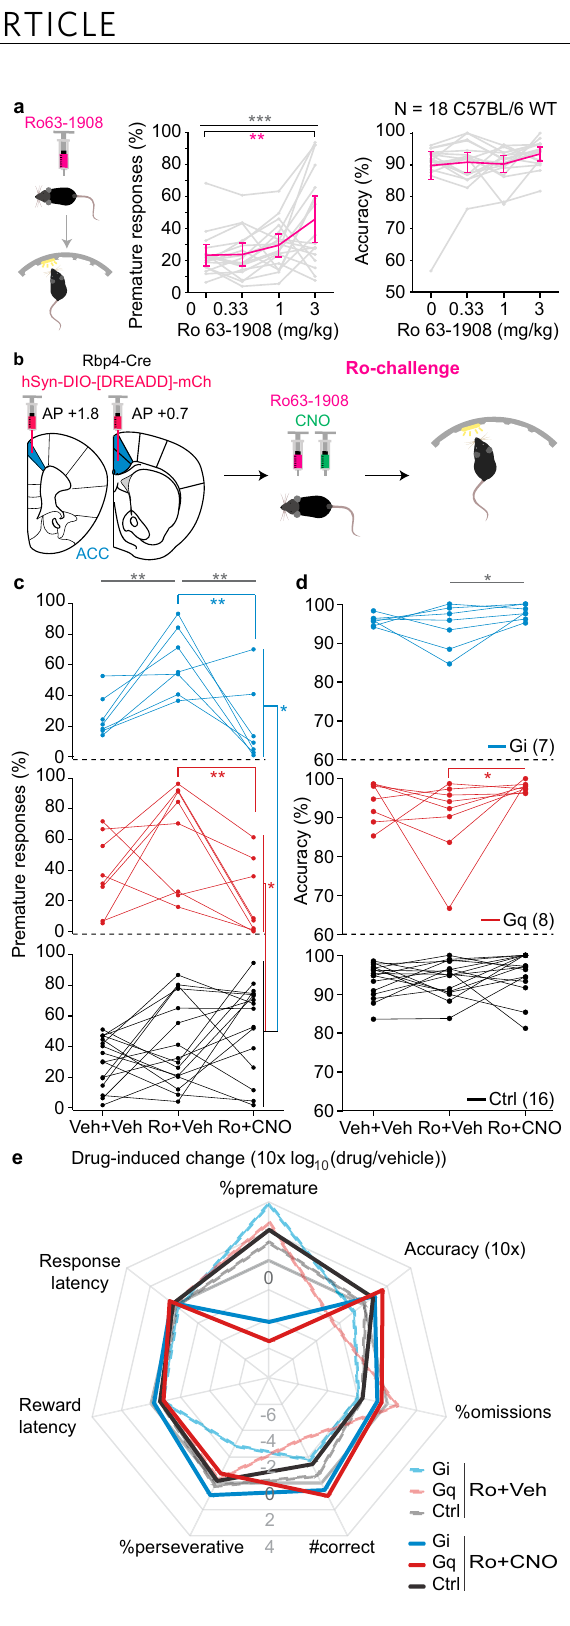
Fig. 3 Activation of the G i -cascade in ACC L5-PCs reduces premature responding in a pharmacological challenge of impulsivity. a Premature responding and accuracy after injection of vehicle (0) or indicated doses of Ro 63-1903 (Ro) in a separate cohort of 18 wildtype mice. Error bars, C.I. b Experimental schedule applying Ro as impulsivity challenge and CNO before testing in the 5-CSRTT in a subset of the DREADD-transduced Rbp4-Cre cohort evaluated in Fig. 2. %premature responses ( c ) and attentional accuracy ( d ) observed after application of 3 mg/kg Ro 63-1908 (Ro) and additional application of CNO (Ro + CNO). 1 mg/kg CNO was used for the G q -group and a subset of Ctrl mice, 10 mg/kg CNO was used for the remainder. In a , c , d , grey asterisks indicate signi fi cant main effect of drug condition across all groups (RM-ANOVA), coloured asterisks below horizontal lines indicate signi fi cant paired post-hoc comparisons between the indicated drug condition (vehicle and 3 mg/kg Ro in a , Ro + Veh and Ro + CNO in c , d ) in the groups indicated by the colour (Sidak); coloured asterisks on the right indicate signi fi cant pairwise post-hoc comparisons between the group indicated by the colour (G i , blue; G q , red; Ctrl, black) at the Ro + CNO condition (Sidak). e Response pro fi les of Ro- (dashed lines of reduced opacity) or Ro + CNO-induced (solid lines) changes relative to the vehicle/vehicle condition measured as log 10 -transform of the within-subject ratio (value after drug/value after vehicle) for relevant behavioural performance parameters on the 5-CSRTT are shown for the three groups as indicated in the legend; grey solid line indicates 0-lattitude (no CNO- induced change). N -numbers for c – e stated in d . See Supplementary Tables 3 and 7 – 10 for reasons for varying N -numbers across experiments, further statistical analysis, and absolute response numbers,